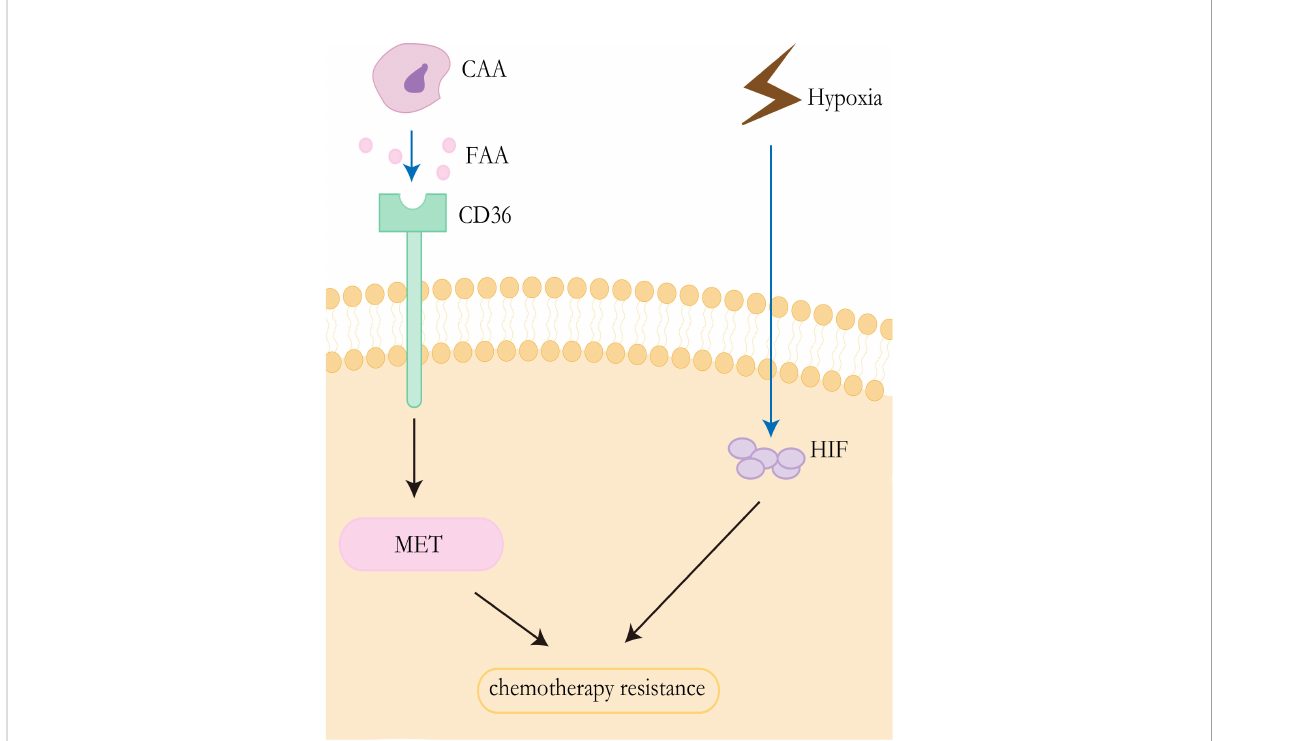
FIGURE 3 Resistance mechanisms of CAAs and hypoxia. CAAs release exogenous free fatty acids, which are absorbed by CD36 on the surface of tumor cells, to promote epithelial mesenchymal transformation and promote drug resistance of HCC. Tumor cells in anoxic environment lead to upregulated EXPRESSION of HIF, thus promoting drug resistance to